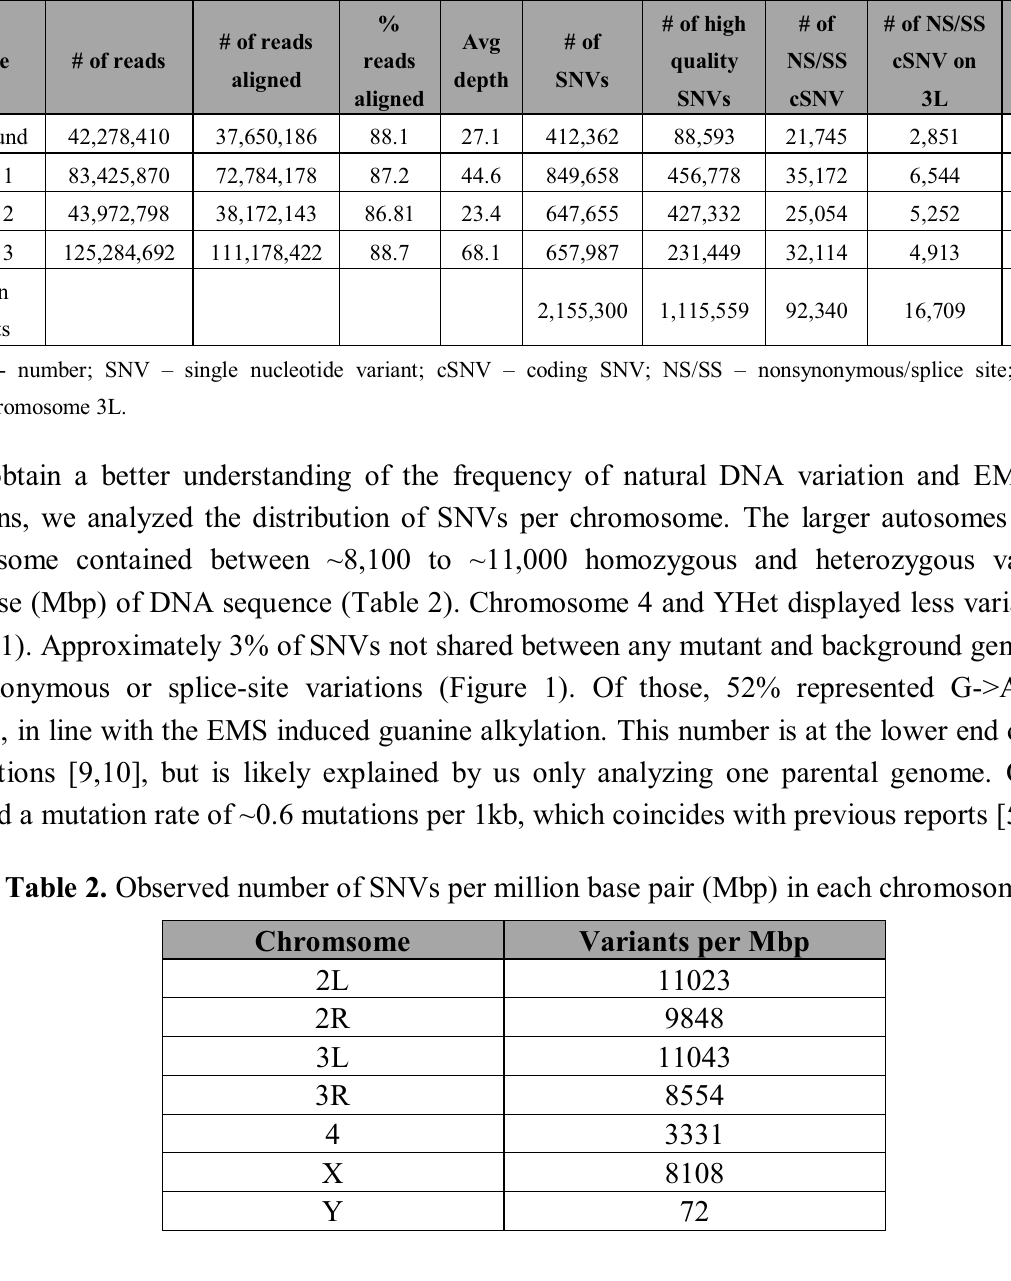
Table 1. Whole genome sequencing metrics per sample.